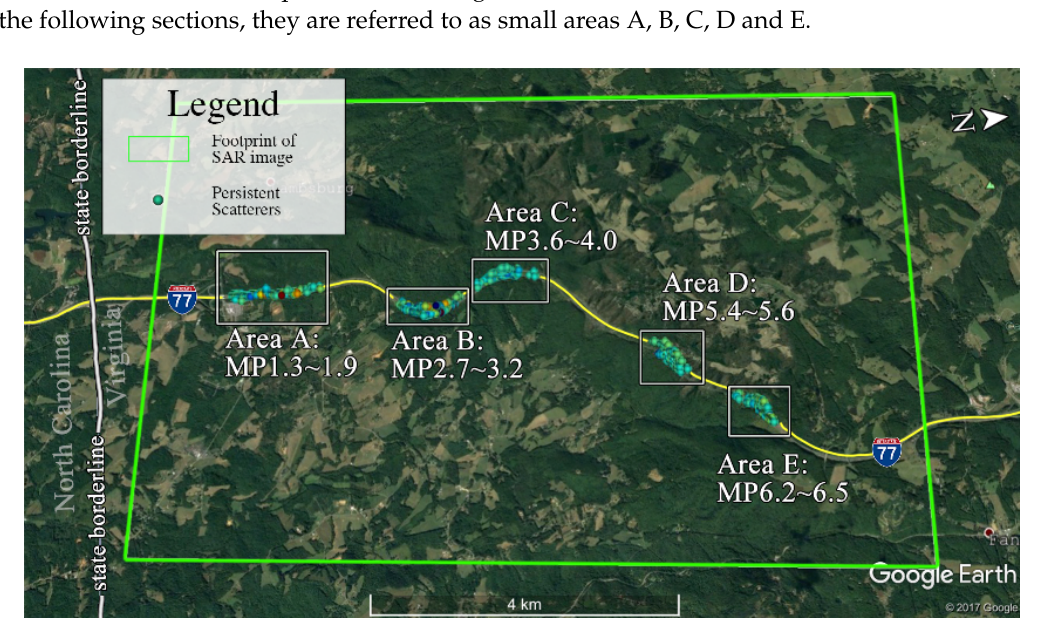
Figure 12. The five small areas inside the AoI. Each small area contains at least one slope of interest and is around 1 to 2 kilometers long. Each area is processed independently with the MTInSAR algorithm described in Section